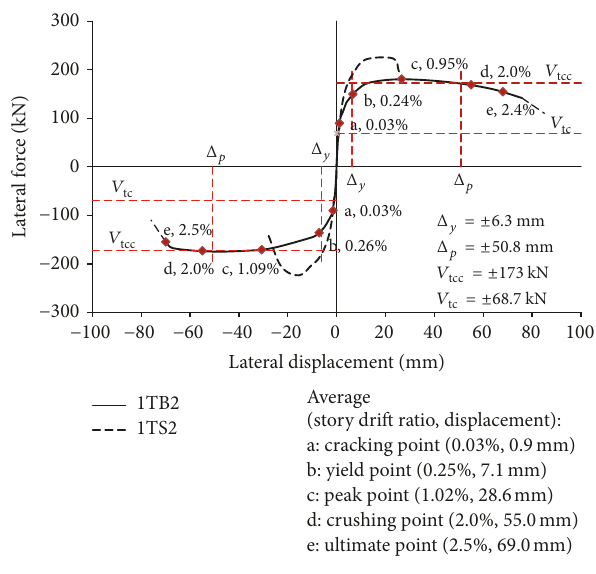
Figure 18: Backbone curves of